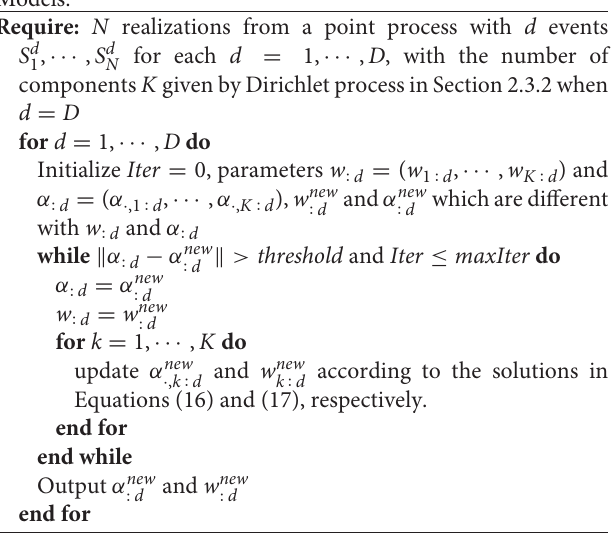
Algorithm 3 Estimate Parameters for Multiple Dirichlet Mixture